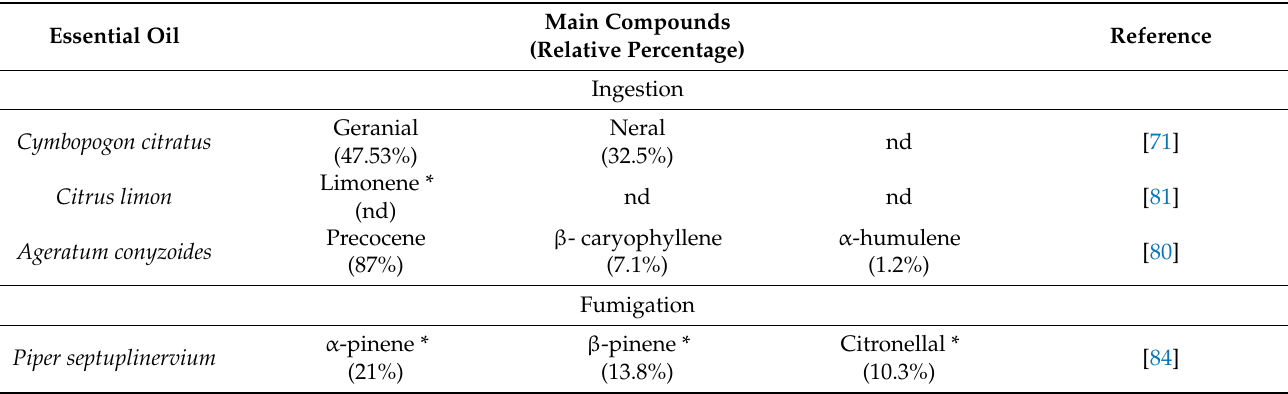
Table 11. Principal components of the most toxic EOs against Spodoptera frugiperda